Question: Judging by this figure, is the value going up or going down?
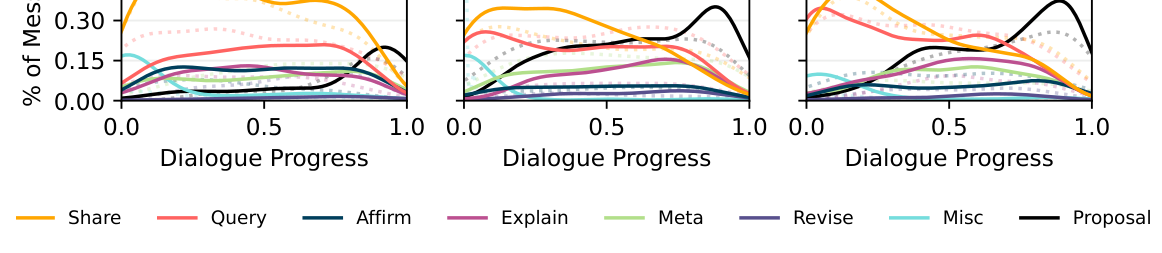
Answer: increasing